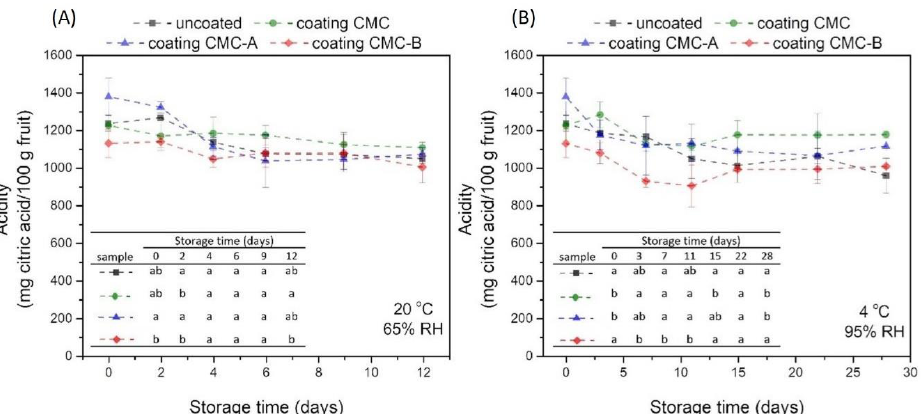
Figure 4. Titratable acidity of the fresh goldenberries (coated and uncoated) as a function of storage time: ( A ) 20 °C and 65% RH; and ( B ) 4 °C and 95% RH. Results are expressed as mean ± standard deviation ( n = 4). In the inserted table, different letters on the same analysis day correspond to statistically different values for a 95% confidence level.